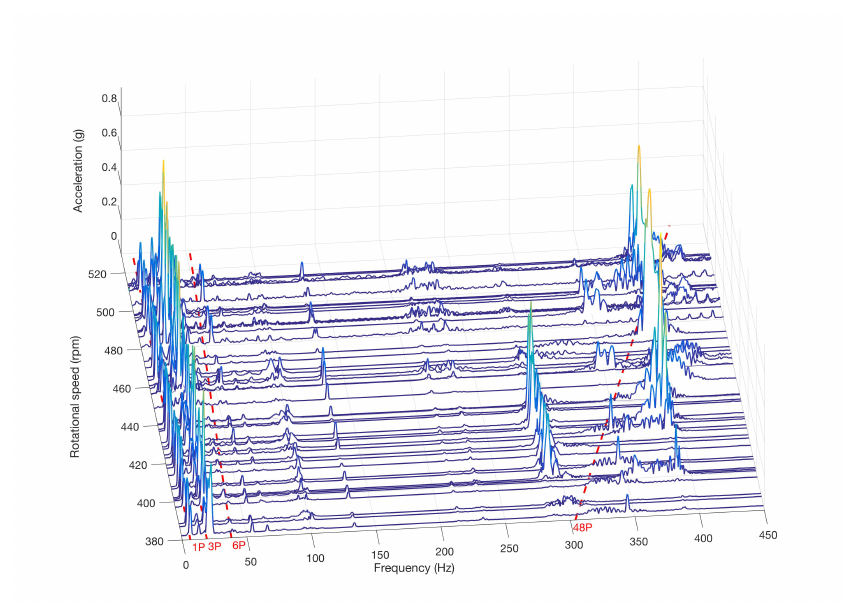
Figure 20. Waterfall of vibration of the tail fin in the Y direction under the oscillatory wind time